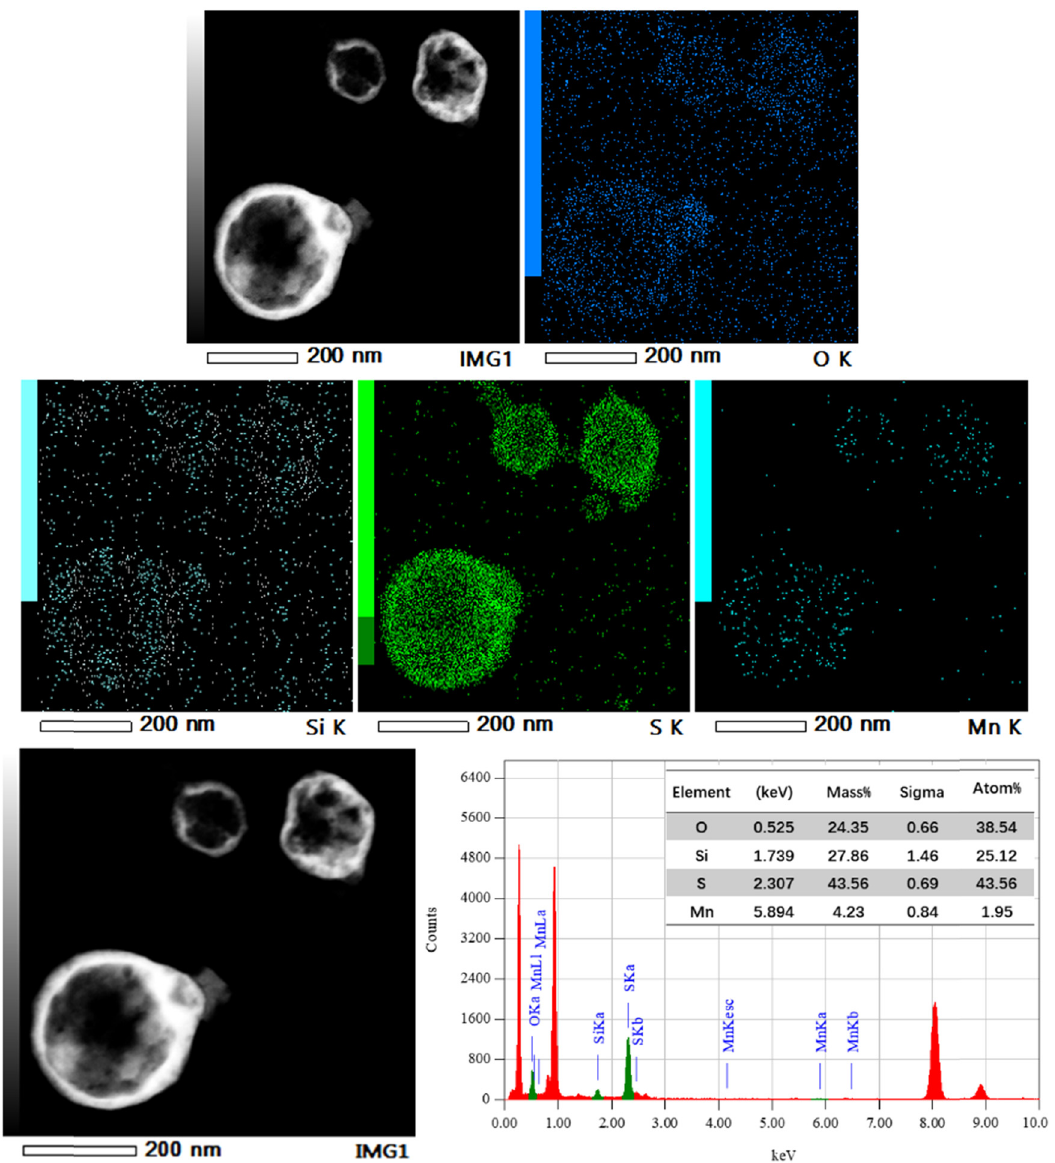
Figure 7: Composition distribution of fi ne precipitates in Y - free